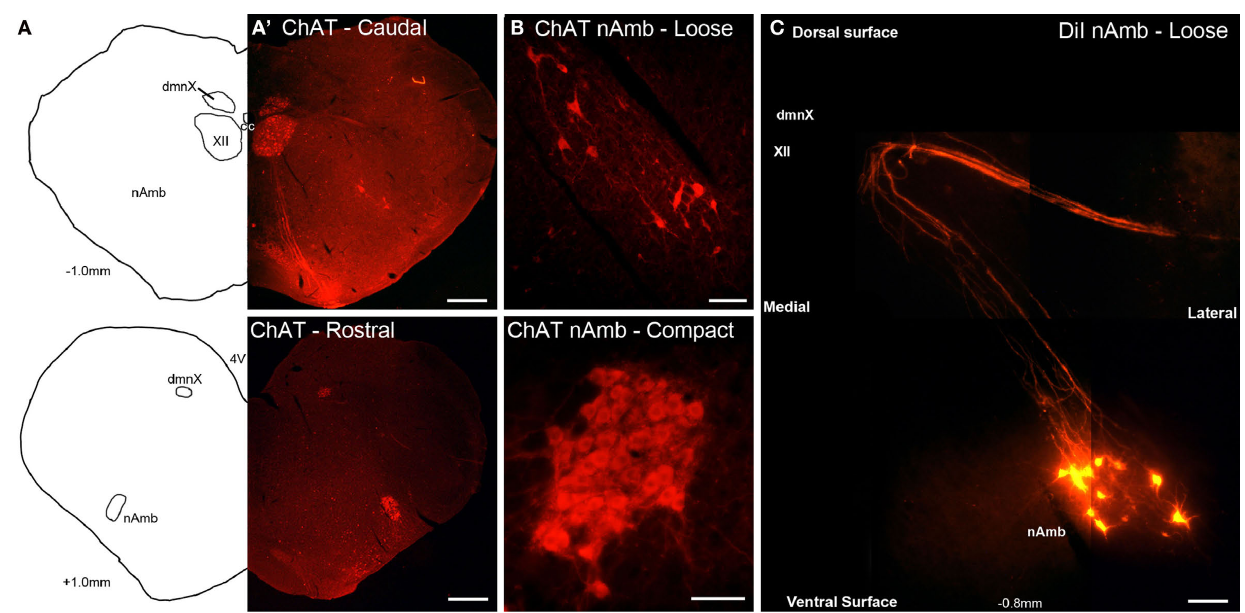
formation and rostral compact formation of the nAmb. (c) Photographic montage showing neurons in the caudal nAmb and their associated axonal projections fluorescently labeled following the application of DiI to the recurrent laryngeal nerve. XII, hypoglossal nucleus; cc, central canal. Co-ordinates indicate the rostral (positive) and caudal (negative) level of the brainstem section relative to the Obex. Scale bars equal 500 μm in (a) and 100 μm in (b,c)